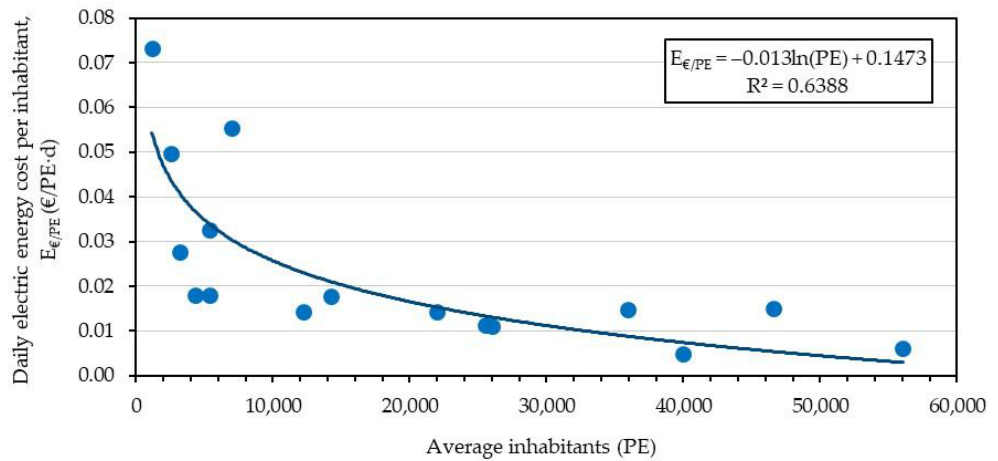
Figure 6. Blue points: daily electricity cost per inhabitant, E € / PE ( € / PE · d) for the 16 examined WWTPs (the WWTP in Thasos is not included due to lack of data); blue line: trend line E € / PE = − 0.013 ln (PE) + 0.1473 with R 2 = 0.6388.